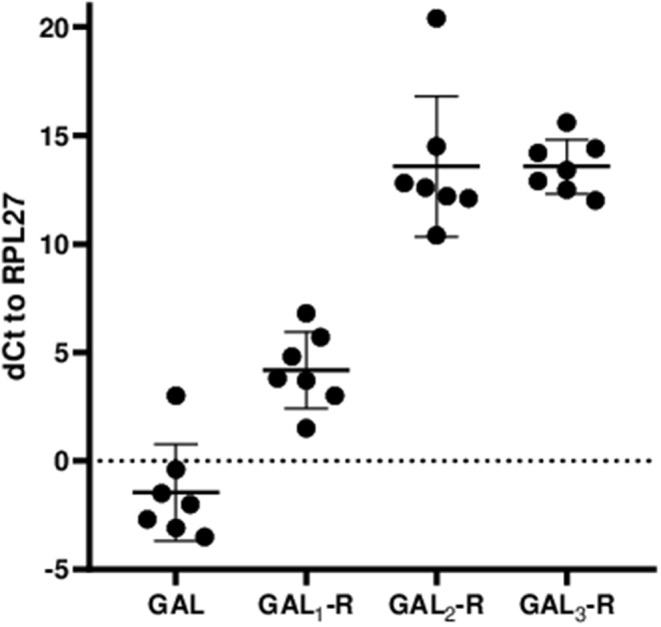
Relative mRNA expression levels of GAL and GALRs in anterior pituitary glands are shown as ΔCt values relative to the human housekeeping gene hRPL27. The values represent mean ± SD (n = 7).